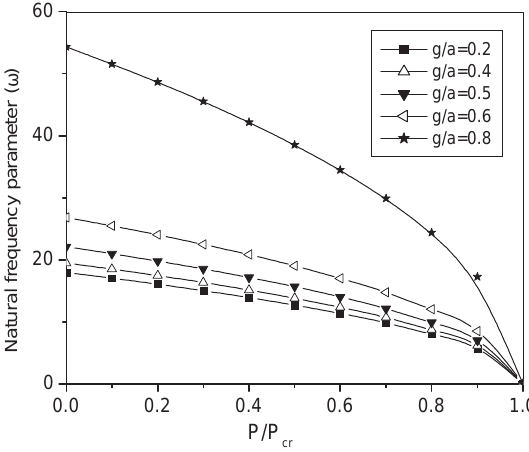
Fig. 15. Frequency parameters for a simply supported stiffened square plates having three equispaced stiffeners with square cutouts subjected to bi-axial compressive forces in various